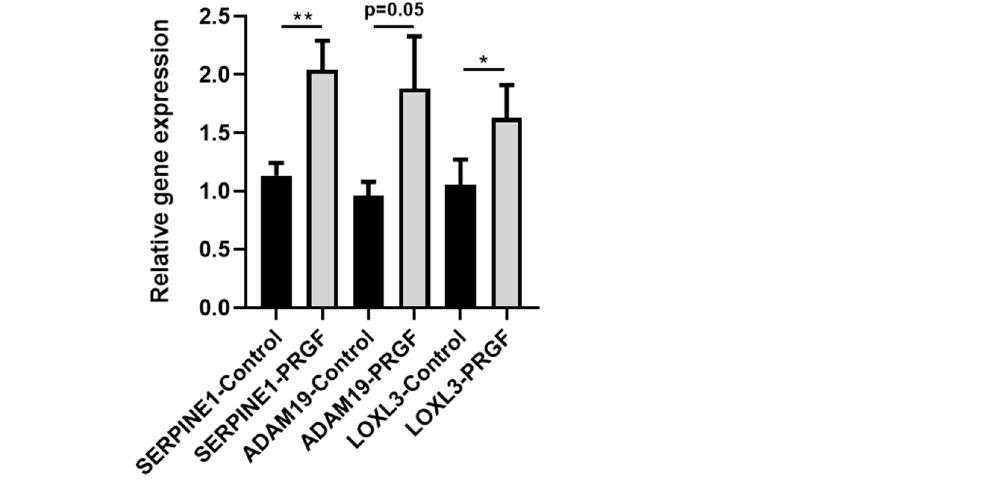
Figure 5. PRGF induces expression of ECM-related genes in skin explants. Human skin explants were stimulated with PRGF for 24. Gene expression was analyzed by real-time PCR. Shown are means ± s.e.m ( n = 9–14; * p < 0.05, ** p < 0.01, Mann-Whitney U test).